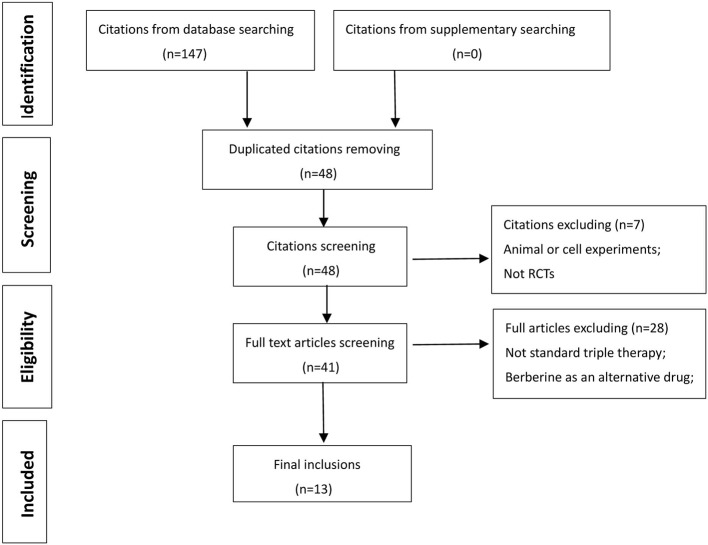
Flow Chart of study selection.